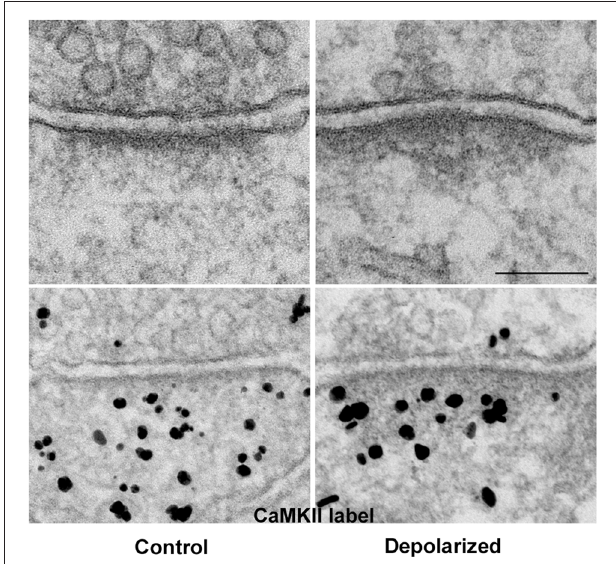
FIGURE 3 | The PSD pallium becomes electron-dense as CaMKII and other proteins are recruited under excitatory conditions. Electron micrographs of asymmetric synapses in cultured hippocampal neurons under basal conditions (left) and after depolarization in medium containing high K + (right). Upon intense synaptic activity the pallium of the PSD becomes electron-dense due to the accumulation of proteins, including CaMKII (bottom panels). Scale bar: 0.1 µ